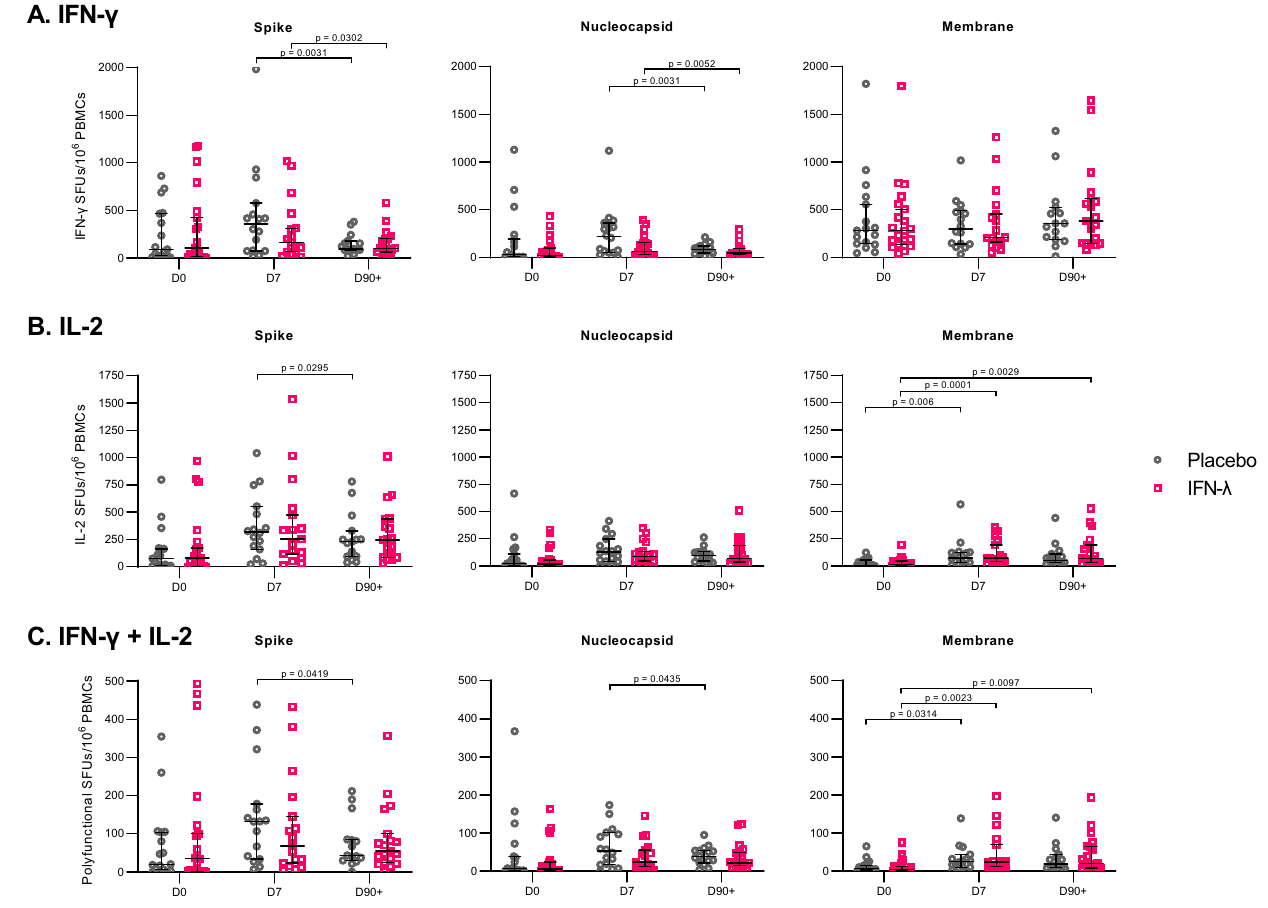
Fig. 3| ComparisonofTcellresponsesbetweenplaceboandPEG-IFN- λ treated COVID-19 patients at day0,day 7, and day90+post enrollment. A IFN- γ B IL-2 C Polyfunctional (IFN- γ +IL-2) T cell responses (as SFUs per 10 6 PBMCs) against structural SARS-CoV-2 protein peptide pools were quanti fi ed ex vivo using FluoroSpot assays. Each dot represents a different patient. N -values are as follows: